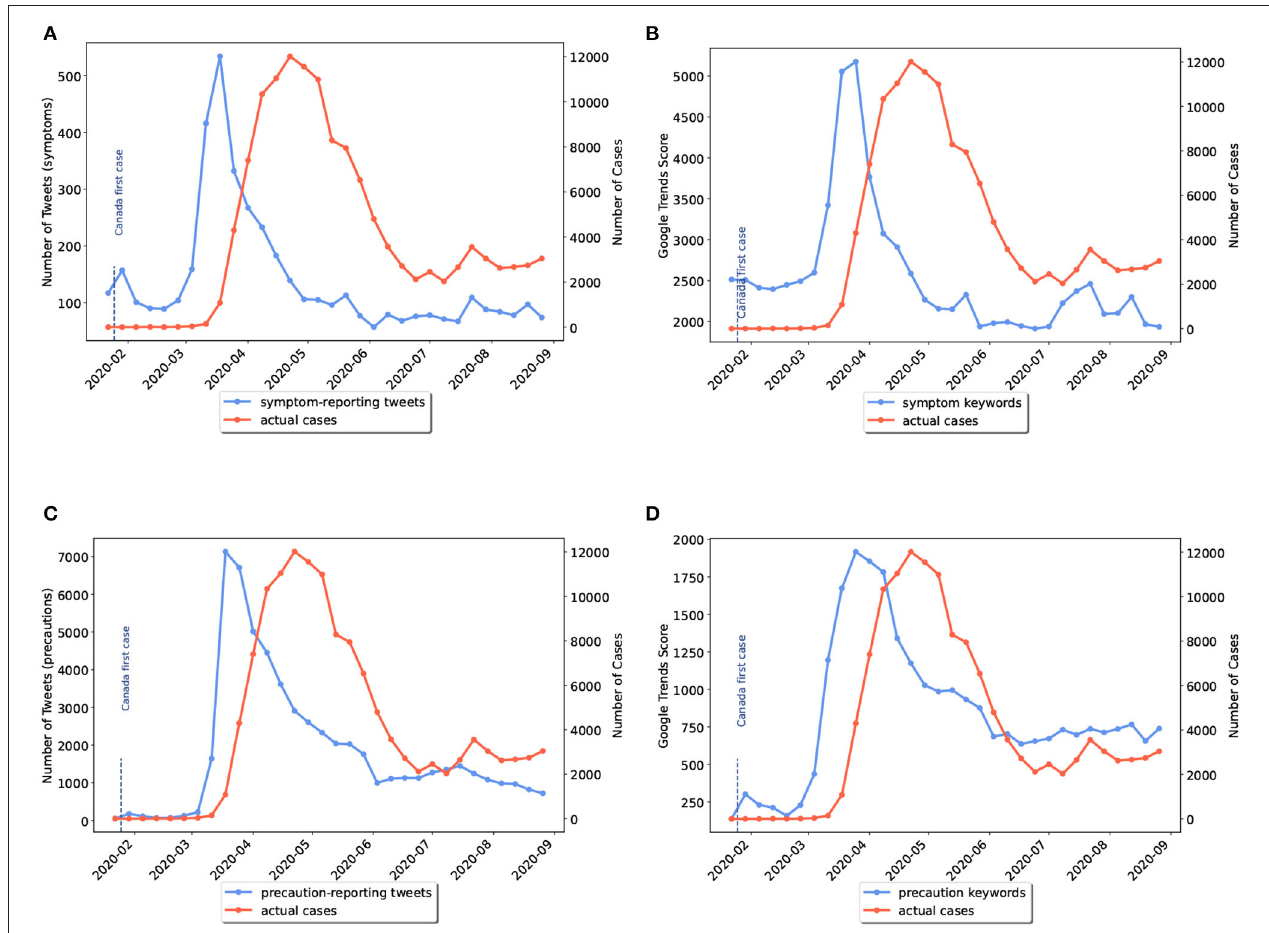
FIGURE 2 | Weekly comparison of online activities and actual number of cases in Canada. (A) Symptom-related tweets vs. cases, (B) Symptom-related searches vs. cases, (C) Precaution-related tweets vs. cases, (D) Precaution-related searches vs. cases.